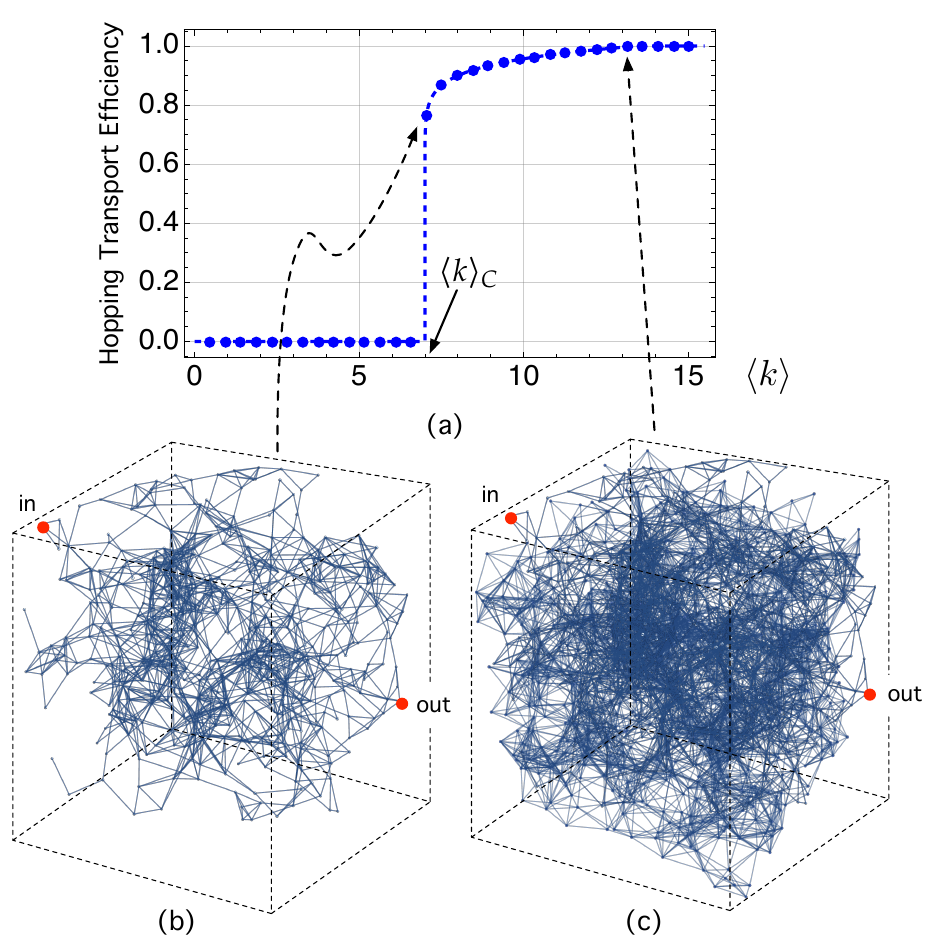
Figure 2. ( a ) Normalized size of the giant component with respect to the total number of nodes, N , as a function of the average node degree . See the main text for further details. (b) Figure 2. ( a ) Hopping transport efficiency, averaged over time, as a function of the average node degree . ( b ) Minimal sub-network (or infinite clustering) for which a carrier in node “in” on k the left side of the sample is able to reach the opposite side in node “out”. The rest of the smaller ⟨ ⟩ sub-networks disconnected from each other have not been drawn for the sake of clarity. ( c ) Complete network with N = 1000 nodes that contains the critical sub-network illustrated in ( b ). See the main text for the corresponding